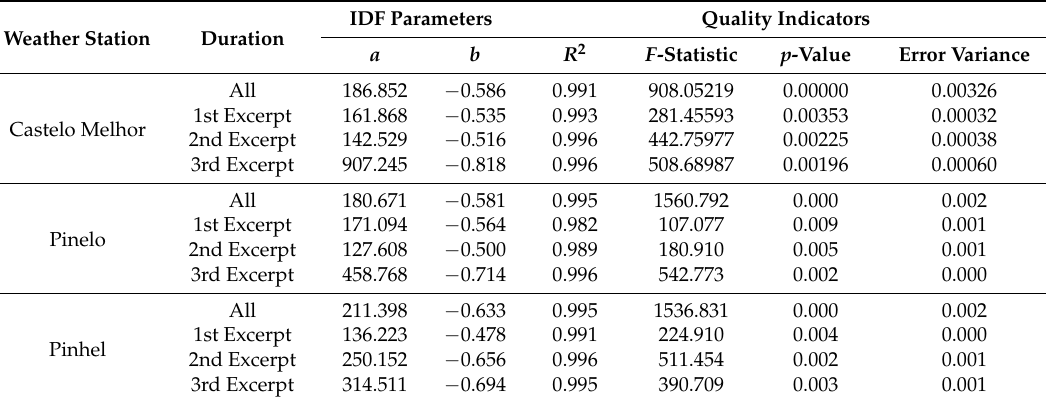
Table 3. Values of the Intensity-Duration-Frequency (IDF) curves’ parameters a and b , estimated with robust regression and the following goodness of fit indicators: coefficient of determination ( R 2 ), F -test statistic ( F -statistic) and correspondent p -value and error variance. Results for the 3 weather stations (Table 1) and return period of 10